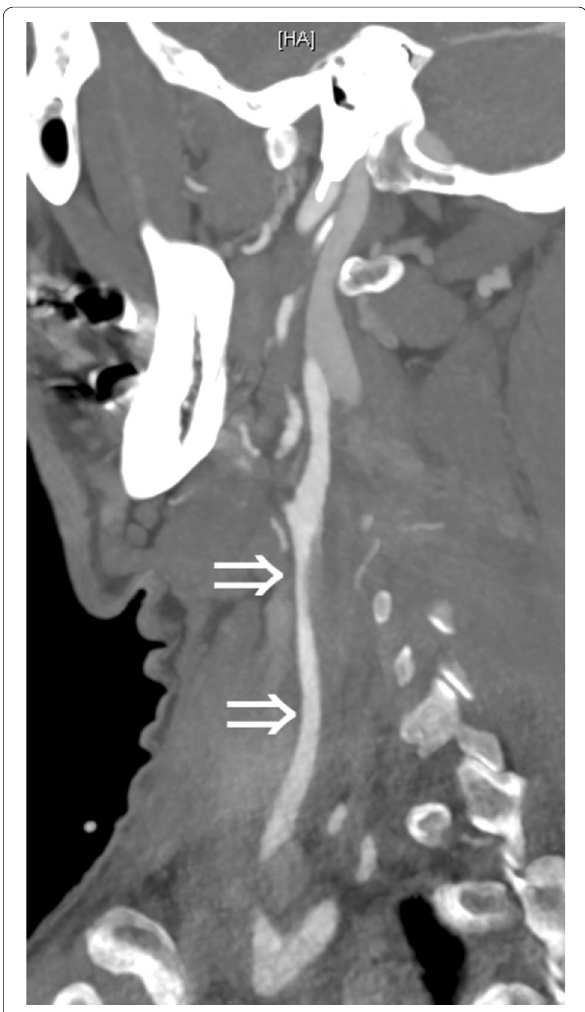
Fig. 1 Computed tomography angiography. On sagittal oblique maximum intensity projection (MIP), an extended and smoothly tapering stenosis of the right common carotid artery is seen